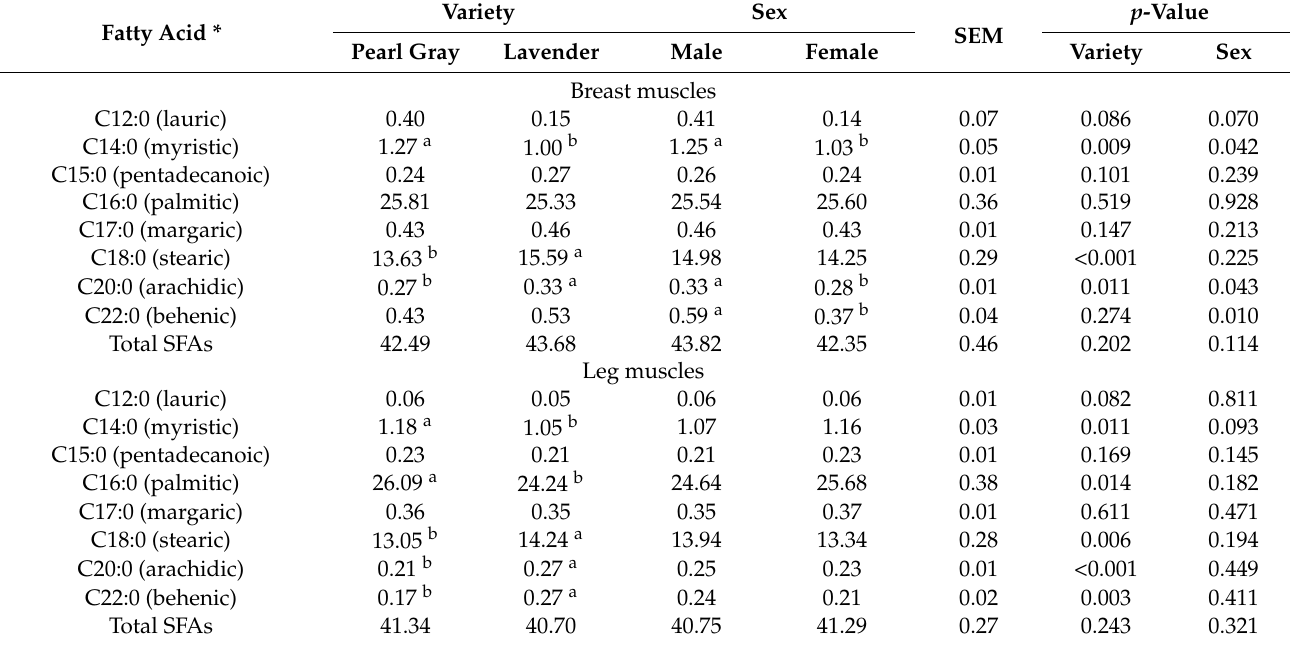
Table 6. Proportions (%) of saturated fatty acids in the total fatty acid pool in the intramuscular fat (breast and leg muscles) of female and male guinea fowl of pearl gray and lavender varieties (means ±